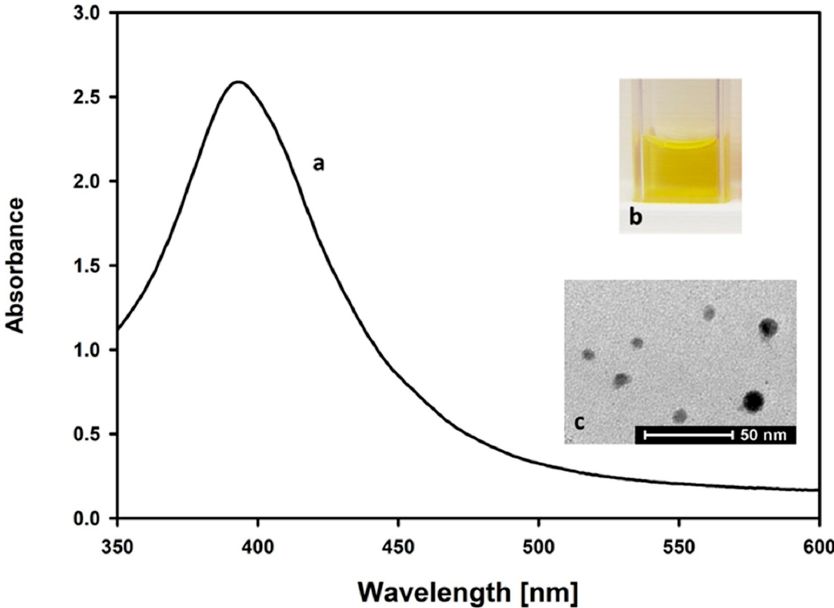
Figure 2. Silver nanoparticles prepared by a chemical reduction of silver nitrate (V) using sodium borohydride: ( a ) characteristic UV-Vis spectrum, with the maximum absorbance at 395 nm, ( b ) color of the solution, ( c ) transmission electron microscope image of the synthesized AgNPs.